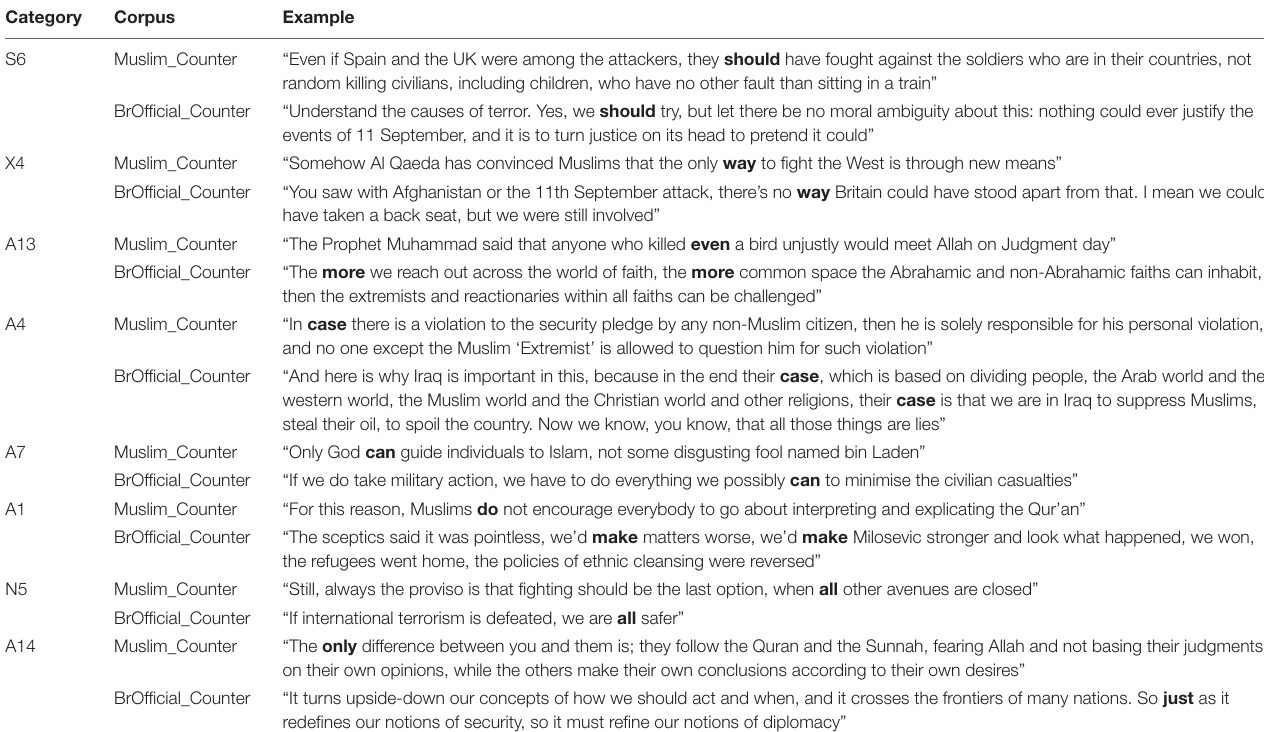
TABLE 3 | Examples of shared conceptual categories between religious authored counter-extremist messages (Muslim_Counter) and British Official authored counter-extremist messages (BrOfficial_Counter). Category Corpus